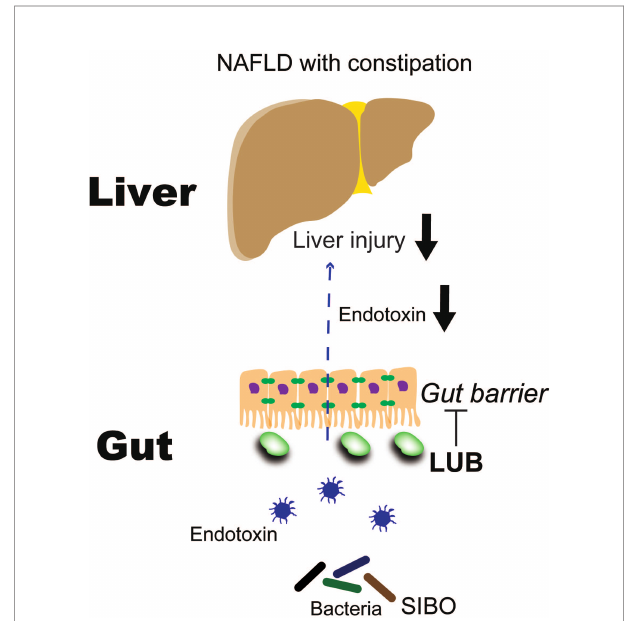
FIGURE 3 | Lubiprostone exerts therapeutic effects on NAFLD by targeting the intestinal barrier (19). LUB, lubiprostone; NAFLD, non-alcoholic fatty liver disease; SIBO, small intestinal bacterial